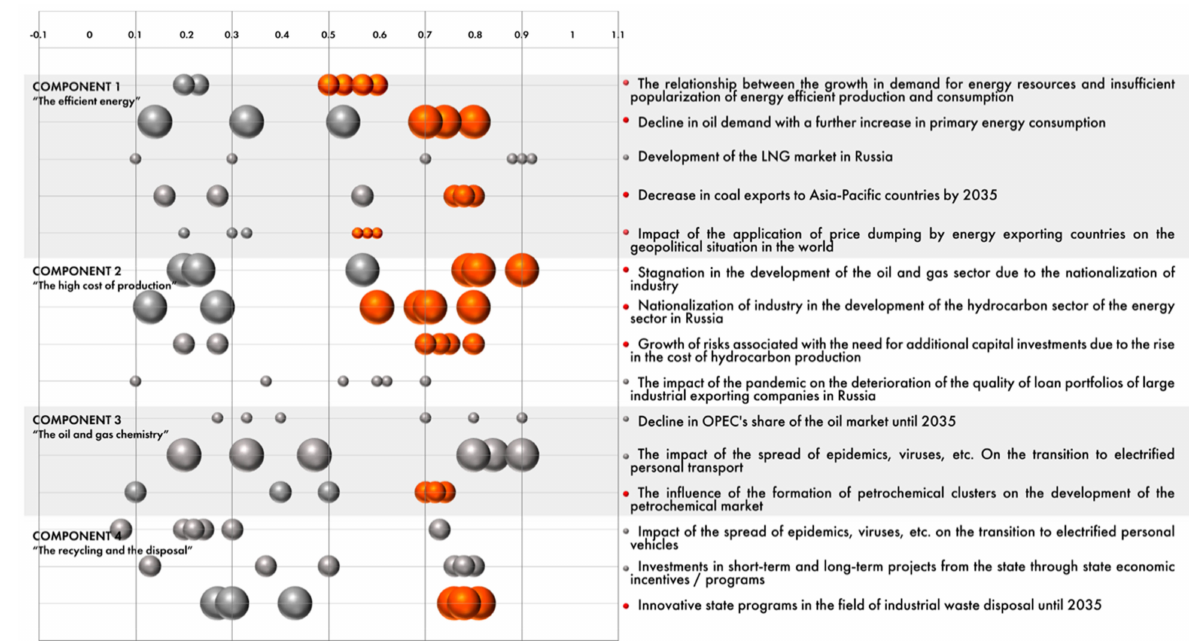
Figure 6. The generalized factorial model of scenario risks (components one to four)